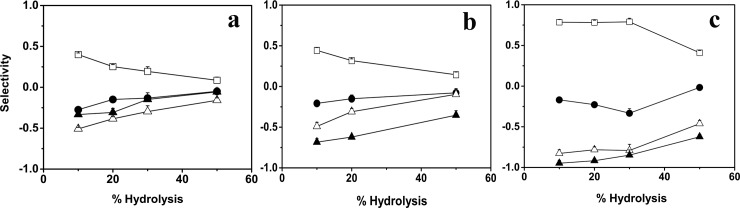
Fatty acid selectivity of GTL and mutants.Fatty acid selectivity of (a) GTL, (b) CM-GTL and (c) DM-GTL at various extents of hydrolysis of anchovy oil. Saturated fatty acids (Open square), mono-unsaturated (Dark circle), EPA (Open triangle) and DHA (Dark Triangle). Selectivity value 0 indicates neutral hydrolysis, 1 indicates total preference and -1 indicates total discrimination (no hydrolysis).